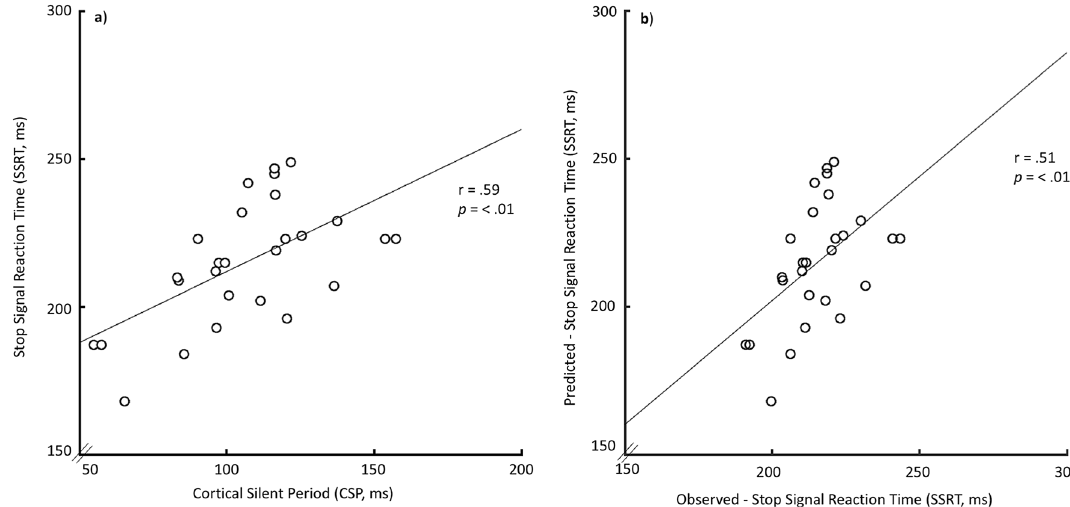
Figure 2. ( a ) Linear association between cortical silent period (CSP) and Stop Signal Reaction Time (SSRT). ( b ) Leave one out cross-validation analysis showing a significant correlation between the model-predicted and observed SSRT